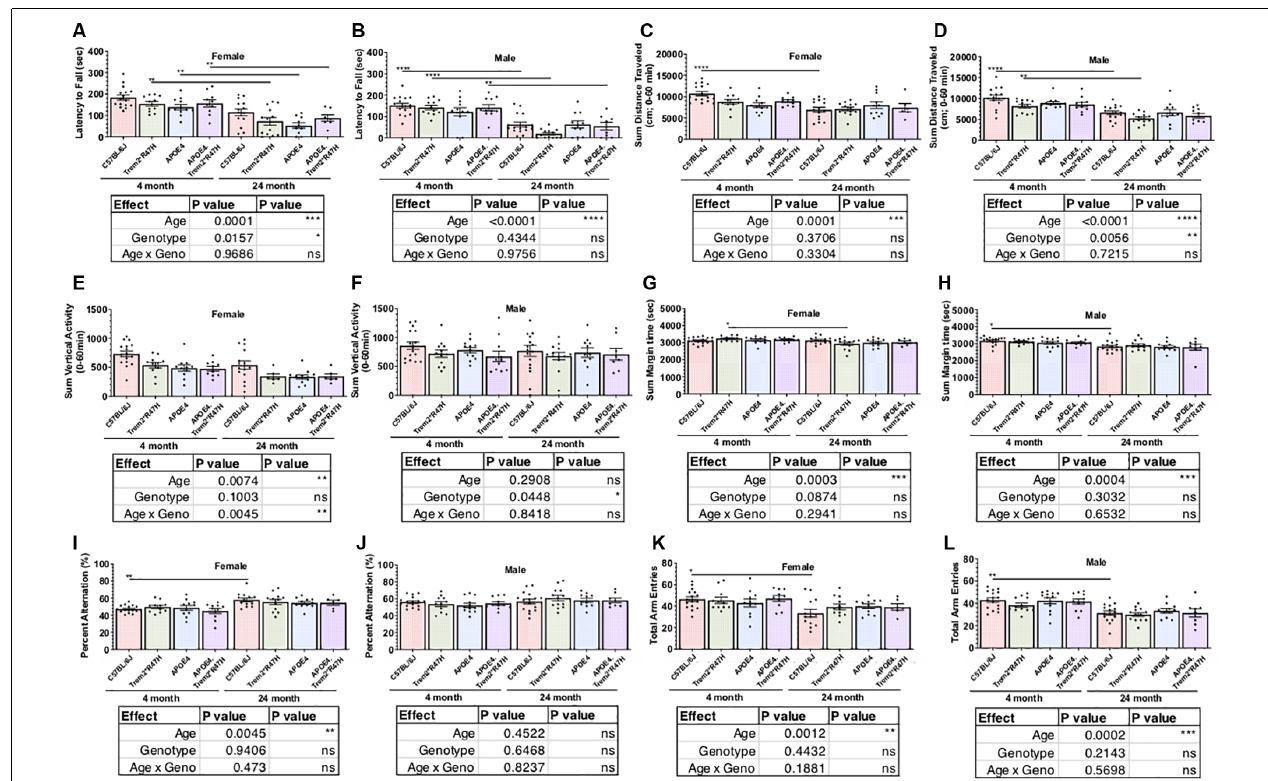
FIGURE 2 | Behavioral testing of LOAD mice to identify functional neurophenotype. Performance of young and aged mice carrying combinations of APOE4 and Trem2*R47H alleles incorporated assays to measure neuromuscular coordination (rotarod; A,B ), locomotor activity (open field; C–F ), exploratory drive (open